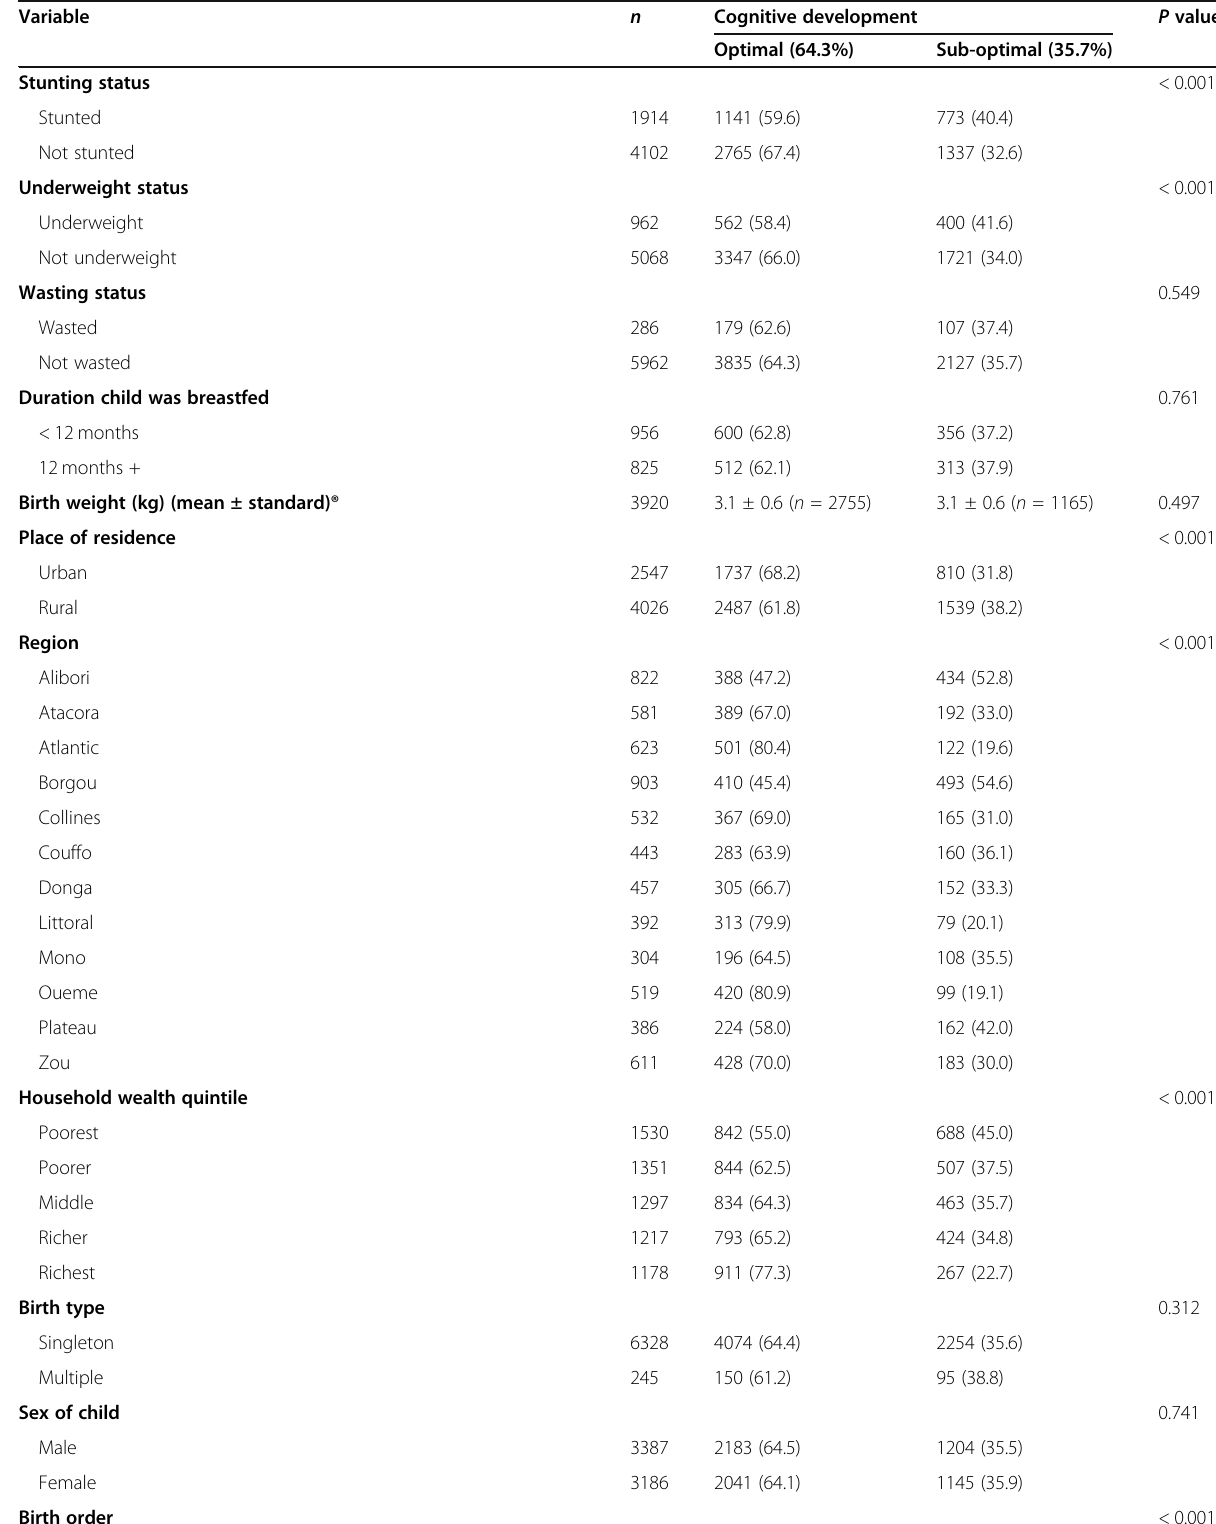
Table 1 The factors associated with under-five cognitive development using Chi-square test